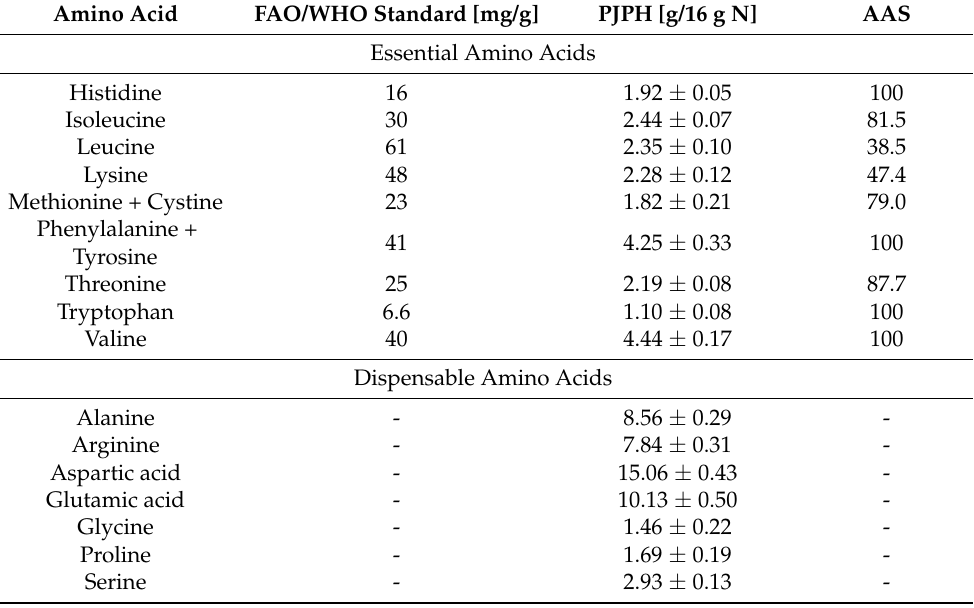
Table 3. The amino acid profile and amino acid score (AAS) for adults according to the standards reported by the FAO/WHO [52]. Amino Acid FAO/WHO Standard [mg/g] PJPH [g/16 g N] AAS Essential Amino